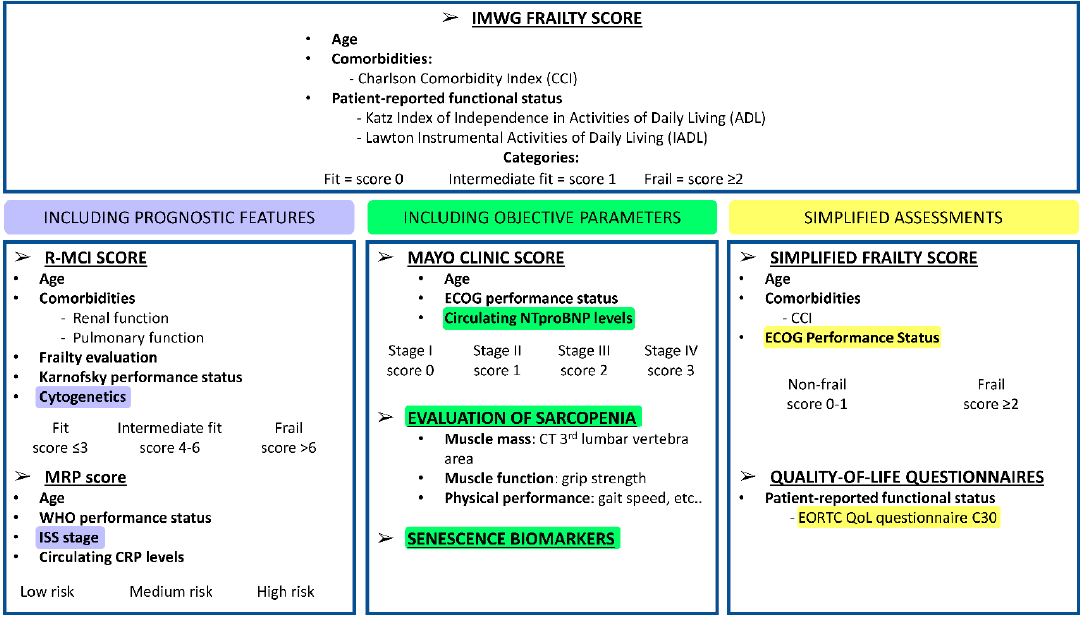
Figure 1. Tools for geriatric assessments in multiple myeloma patients. International Myeloma Working Group (IMWG) frailty score [29]; Revised Myeloma Comorbidity Index (R-MCI) [33]; UK